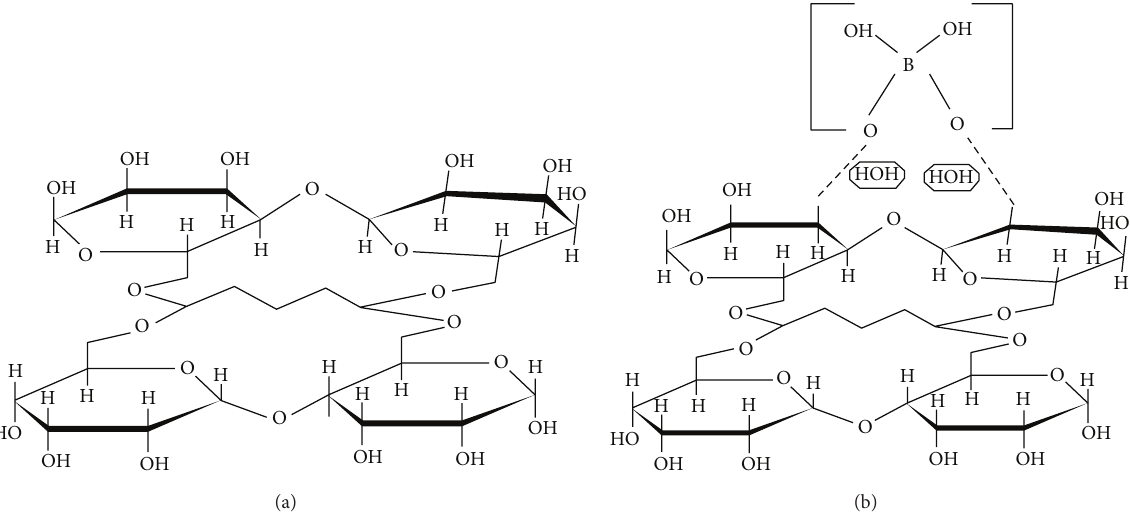
Figure 5: Structure of potato starch with GA (a) before and (b) after complexation.